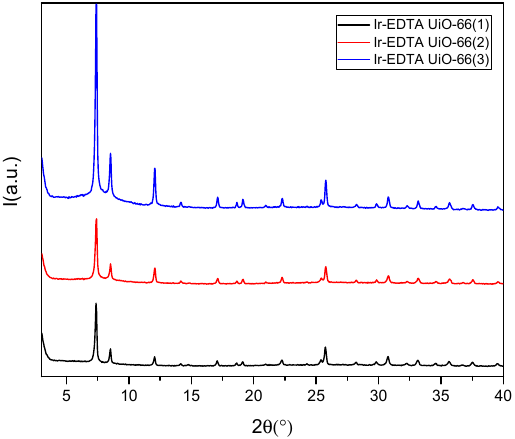
Figure 4. XRPD pattern of IrEDTA@UiO66(1) black, (2) red and (3) blue.